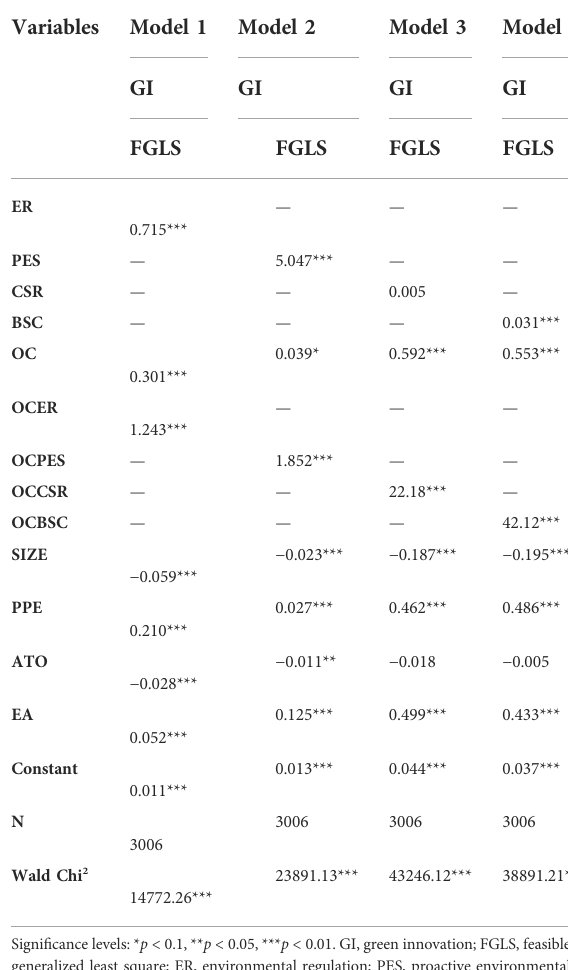
TABLE 8 Robustness of moderating role of OC. TABLE 7 Robustness of moderating role of